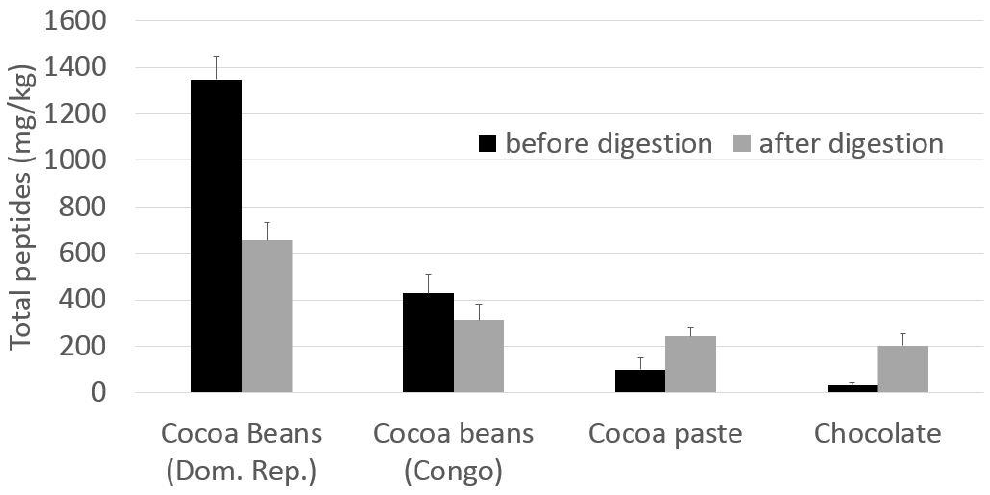
Figure 2. Peptides amount (mg / kg) in digested sample compared to the amount in the respective non-digested samples. Peptides were quantified as ratio of peptides area vs. internal standard area (phe-phe) and referred to the initial cocoa amount, making the raw assumption that the specific response factor for each peptides is equal to 1. The total peptides amount is referred to the sum of peptides listed in Table 1.